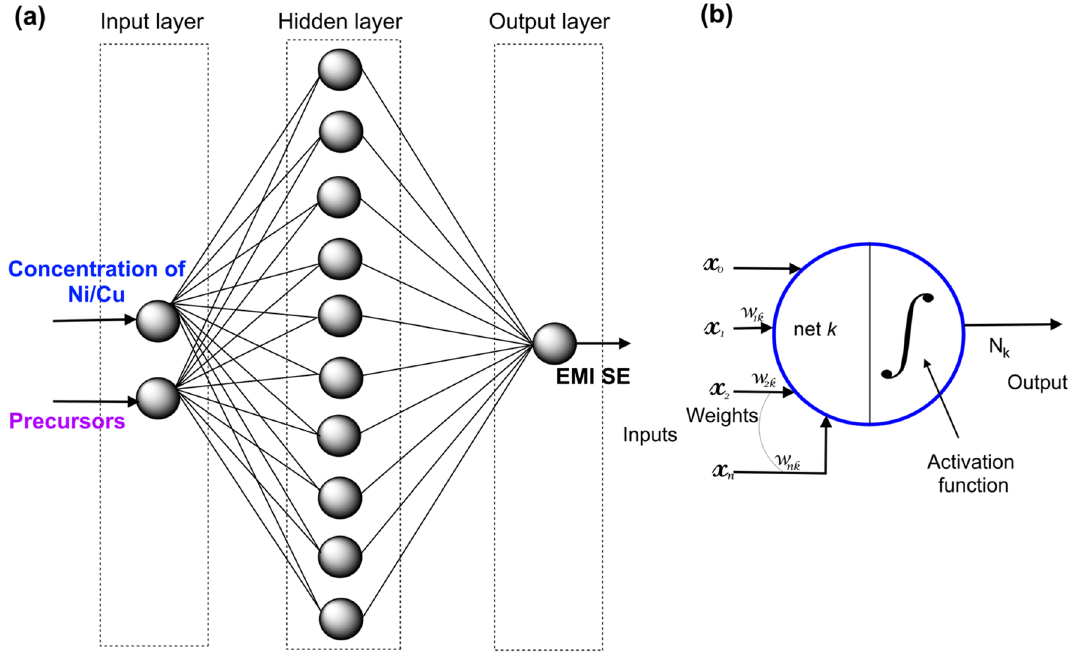
Figure 10. ANN architechure ( a ); architechure of individual neuron ( b